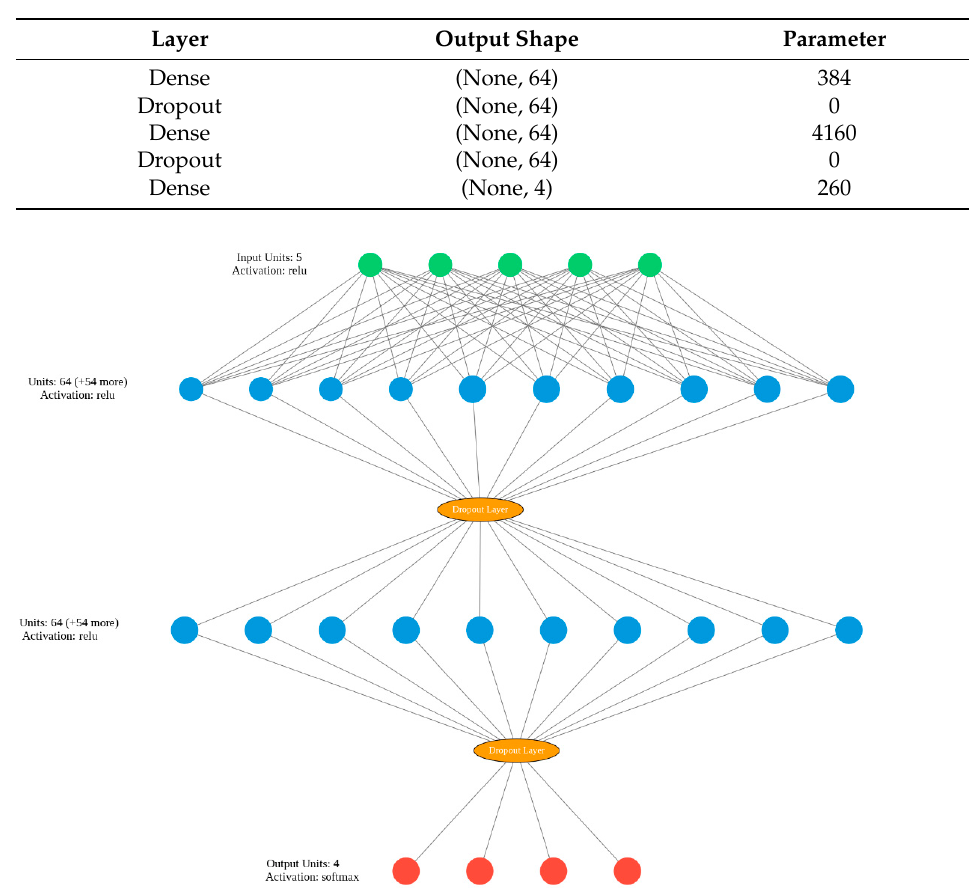
Table 2. Model architecture summary.